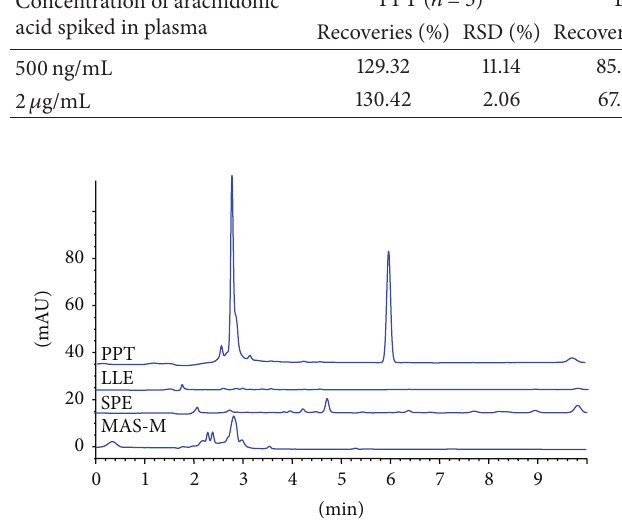
Figure 4: Chromatograms of proteins in samples treated with various clean-up methods, where PPT is Method A, LLE is Method B, SPE is Method C, and MAS-M is Method D.